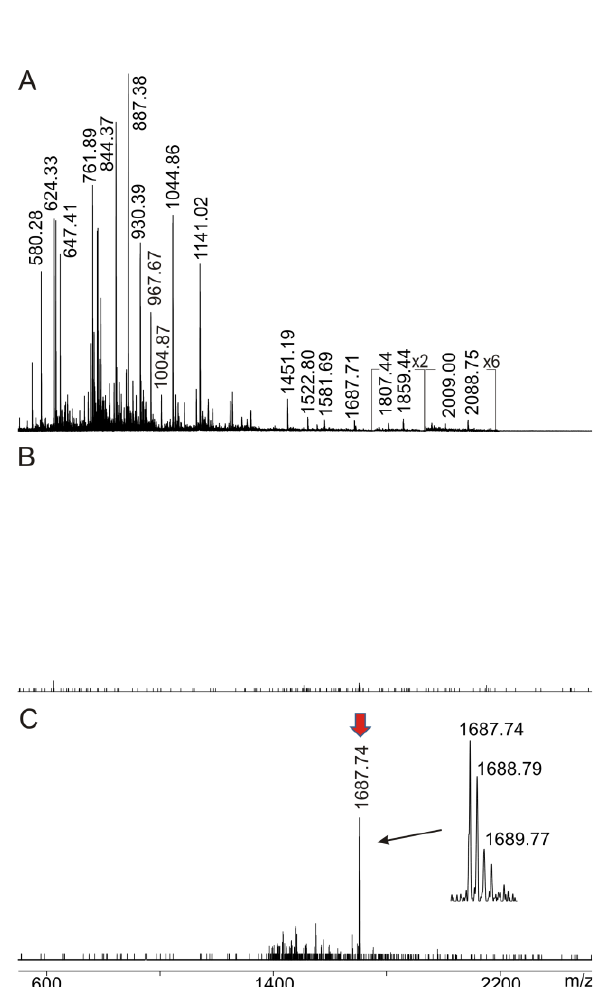
Figure 4. ITEM—ONE analysis. ( A ) NanoESI mass spectrum of ions from Ovalbumin upon tryptic digestion (solution 2′). Ion intensity multiplication factors are provided. ( B , C ) NanoESI mass spectrum of ions from mixture (solution 3a) of tryptically digested Ovalbumin (solution 2′) with anti-Ovalbumin mAb (solution 1a). Ion transmission below m / z 1450 is completely suppressed. ( B ) ∆ CV: 3 V. ( C ): ∆ CV: 20 V. Selected m / z values are provided. The red arrow points to the complex-released epitope peptide ion signal. The insert in ( C ) shows the isotope pattern of the complex-released peptide ion signal. Protein concentration is 0.22 µg/µL. 2.5 µL were loaded. Solvent: 200 mM ammonium acetate, pH 6.7. 1 min recording time per spectrum. 30% baseline